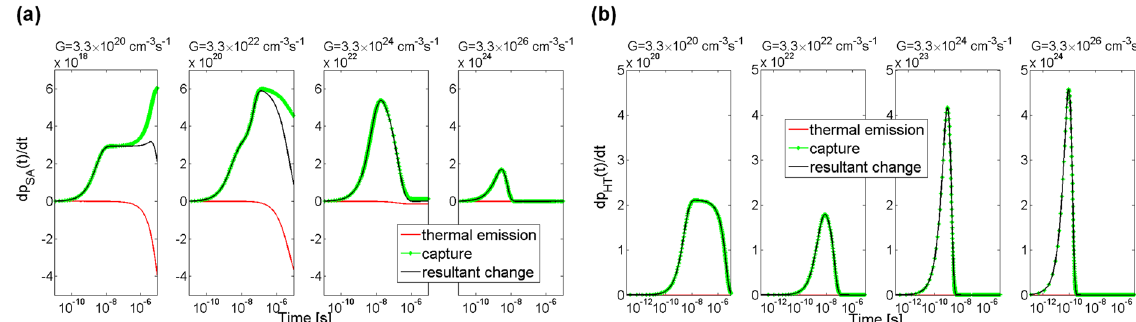
Figure 9. Simulation of the rate of change in hole concentration at trap levels SA ( a ) and HT ( b ) in 4H-SiC material. The green lines show rates of capturing holes from the valence band, the red lines show rates of thermal emission of excess holes from the traps to the valence band, and the black lines overlaid in most cases on the green ones are a resultant rate of change in hole concentration as an effect of simultaneous occurrence of the capturing and thermal emission processes. Parameter G is the generation rate coefficient.